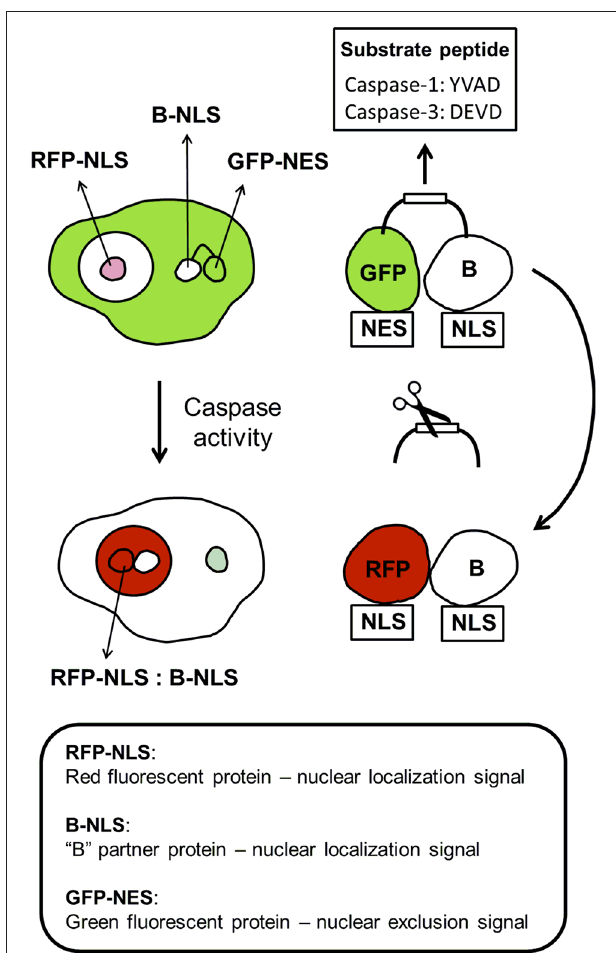
FIGURE 5 | Components of protein dimerization-based sensors for caspase-1 and caspase-3. The dimerization-based caspase biosensor relies on the expression of two plasmid-encoded, dimerization-dependent fluorescent proteins: (1) a green fluorescent protein tagged with a nuclear exclusion signal (GFP-NES) and linked to a partner protein “B” tagged with a nuclear localization signal (B-NLS) by a caspase substrate peptide (Caspase-1: YVAD; Caspase-3: DEVD), and (2) a red fluorescent protein tagged with a nuclear localization sequence (RFP-NLS). Caspase activation causes the substrate cleavage. B-NLS translocates to the nucleus, where it binds to RFP-NLS. The binding of B-NLS, which itself is non-fluorescent, to GFP-NES or RFP-NLS increases the fluorescence of either dimerization-dependent fluorescent proteins many folds. Thus, cells expressing the caspase biosensor show green fluorescence in the cytoplasm when caspase activity is low and red fluorescence in the nucleus with increased caspase